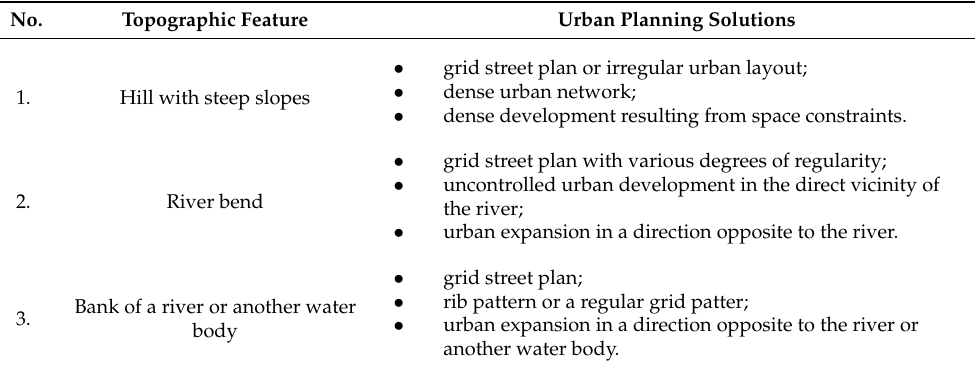
Table 2. Correlations between landform and urban planning solutions.